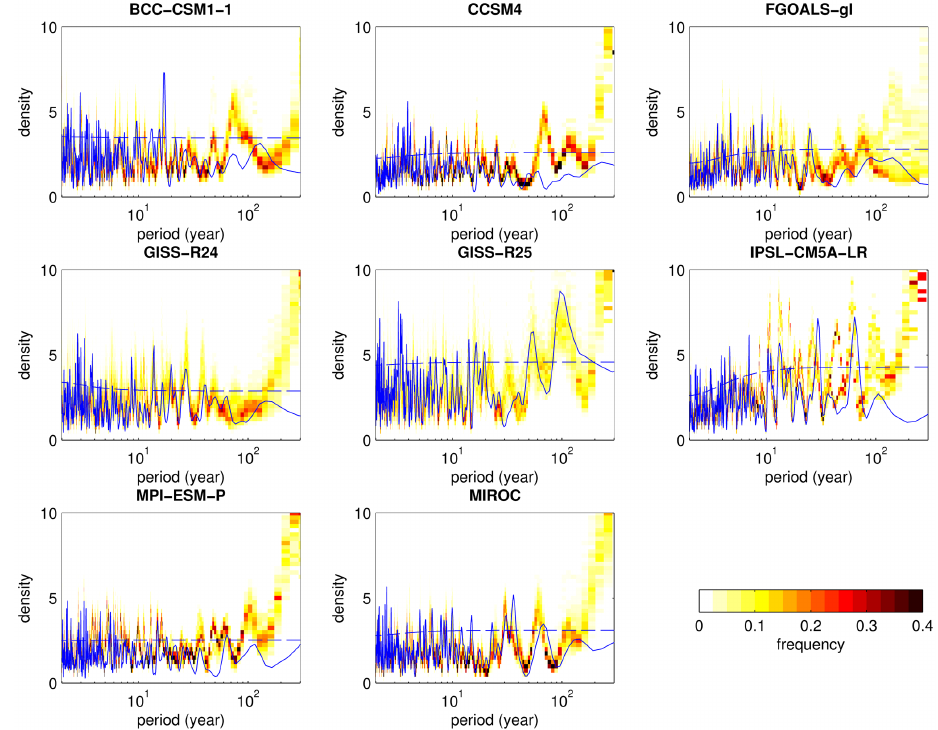
Figure 10. Power spectral density of the winter PNA index (blue line) for individual simulations with associated 95% confidence level (blue dashed line) and agreement between the spectra of the pseudo-reconstructions (shading) obtained following an approach similar to TT2010 and illustrated in Figs. 7a and 8. Agreement is defined, for a given frequency, as the fraction of total pseudo-reconstructions having power within 0.1units 2 yr − 1 intervals. All indices are standardized according to the 1950–1999 climatology.